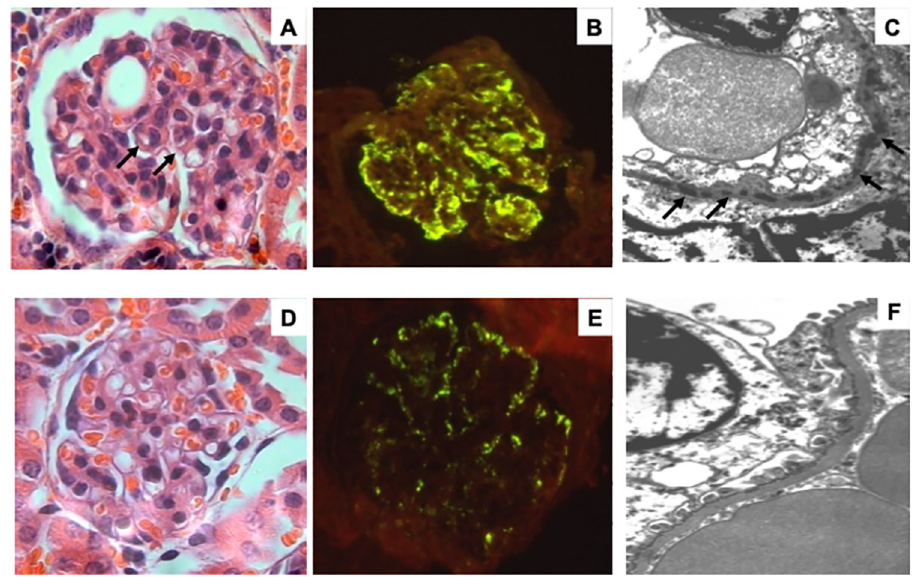
Fig 7. Histology of kidneys from pristane-treated mice co-vaccinated with D2/IL-10 or D2/IFN- γ . Representative histological and ultrastructural changes in the kidney from female BALB/c mice vaccinated with D2/IL-10 or D2/IFN- γ . Panel A) Light micrograph from IFN- γ /D2 co-vaccinated mouse showing a hypercellular glomerulus with mesangial matrix widening and thick capillary walls (arrows). Panel B) Immunofluorescence photograph taken from the same mouse (A) shows numerous mesangial and intramembranous IgG immune complexes. Panel C) Abundant electron- dense intramembranous deposits (arrows) are showed in this electron microscopy micrograph taken from the same IFN- γ /D2 prophylactic co-vaccinated mouse. Panel D) In contrast, lower cellularity and thinner capillary membranes are seen in this glomerulus from IL-10/D2 prophylactic co-vaccinated mouse. Panel E) The glomeruli from the same IL-10/D2 co-vaccinated mouse showed lesser immune complexes in the immunofluorescence. Panel F) in electron microscopy study (all light and fluorescence micrographs 100x, electron microscopy micrographs 25,000x).